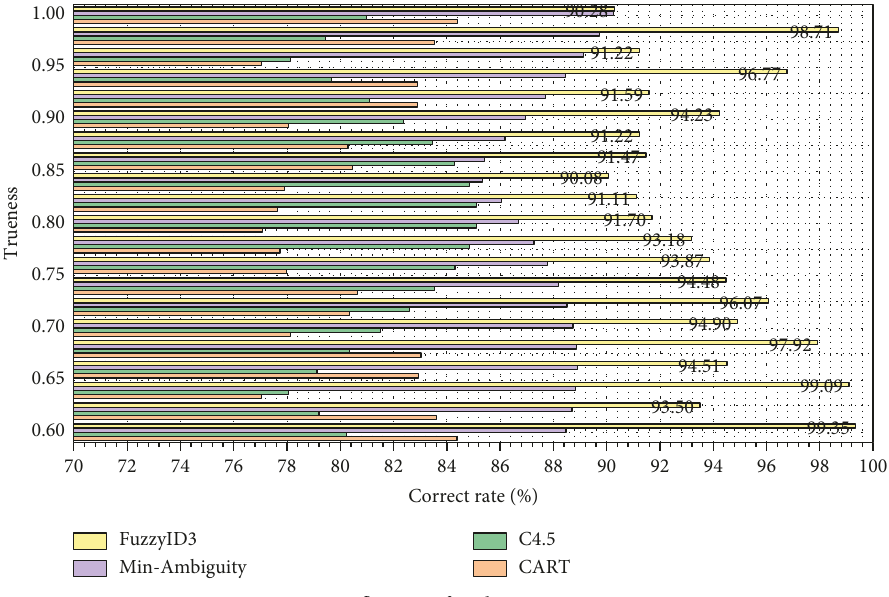
Figure 5: Influence of realism on